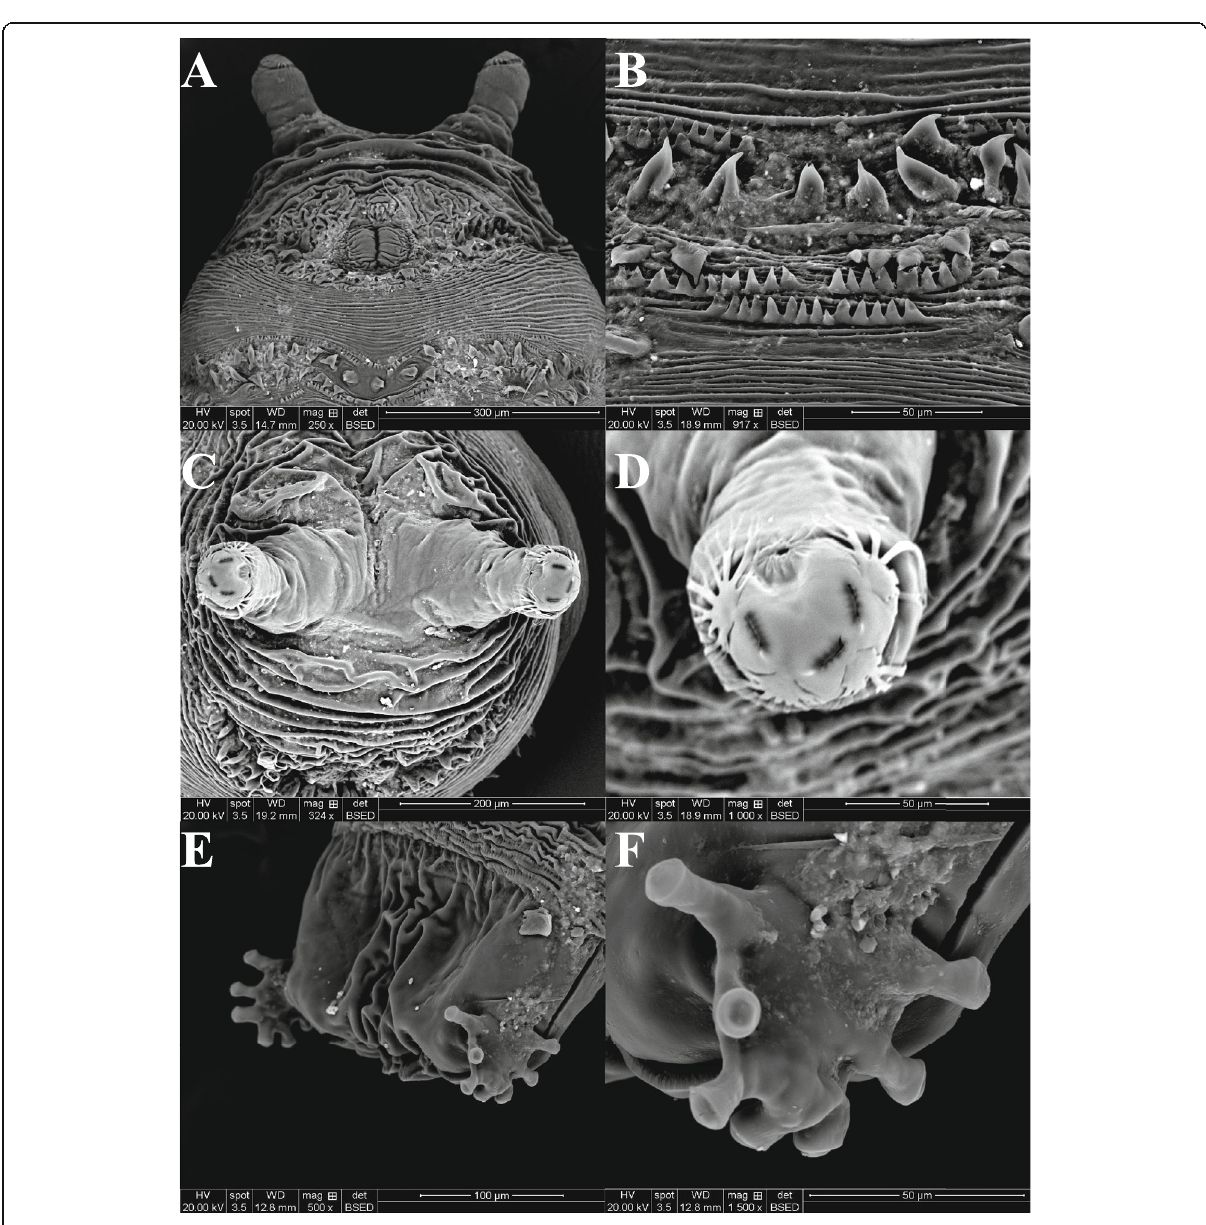
Fig. 3 Phthitia empirica puparium details. Anal plate ( a ), intersegmental spicules ( b ), posterior region with spiracles ( c ), detail of the posterior spiracle ( d ), anterior region with anterior spiracles ( e ), and detail of the anterior spiracle ( f ) (scale bar is reported in each frame)